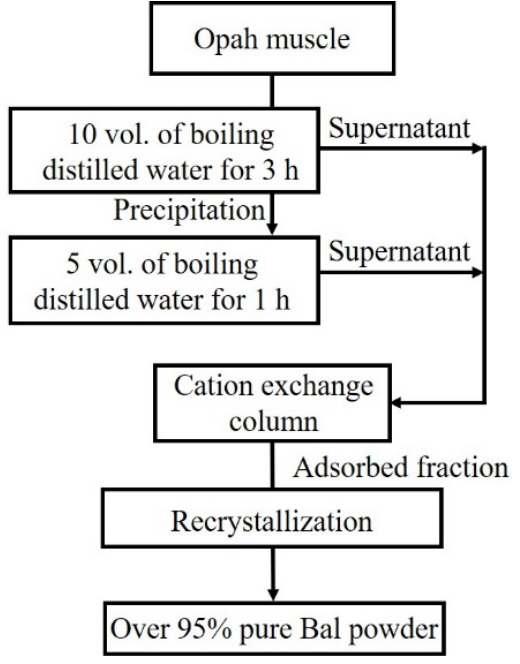
Figure 1. Schematic representation of the study design. Balenine was prepared from opah muscle through boiling, ion-exchange, and recrystallization treatments.